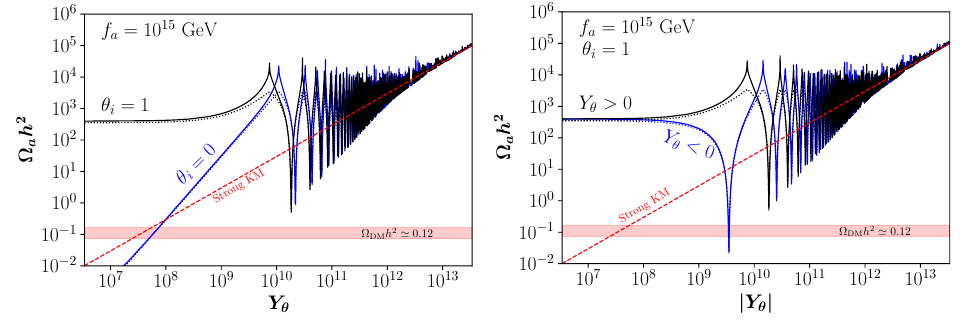
Figure 2. Weak KM. Axion relic abundance for f a = 10 15 GeV. Left panel : θ i = 1 (black) and θ i = 0 (blue) for Y θ > 0. Right panel : Y θ > 0 (black) and Y θ < 0 (blue), for θ i = 1. We show a comparison between numerical results (solid) and the analytical approximation with a quadratic QCD axion potential (dotted). The dashed red line shows the limit of strong